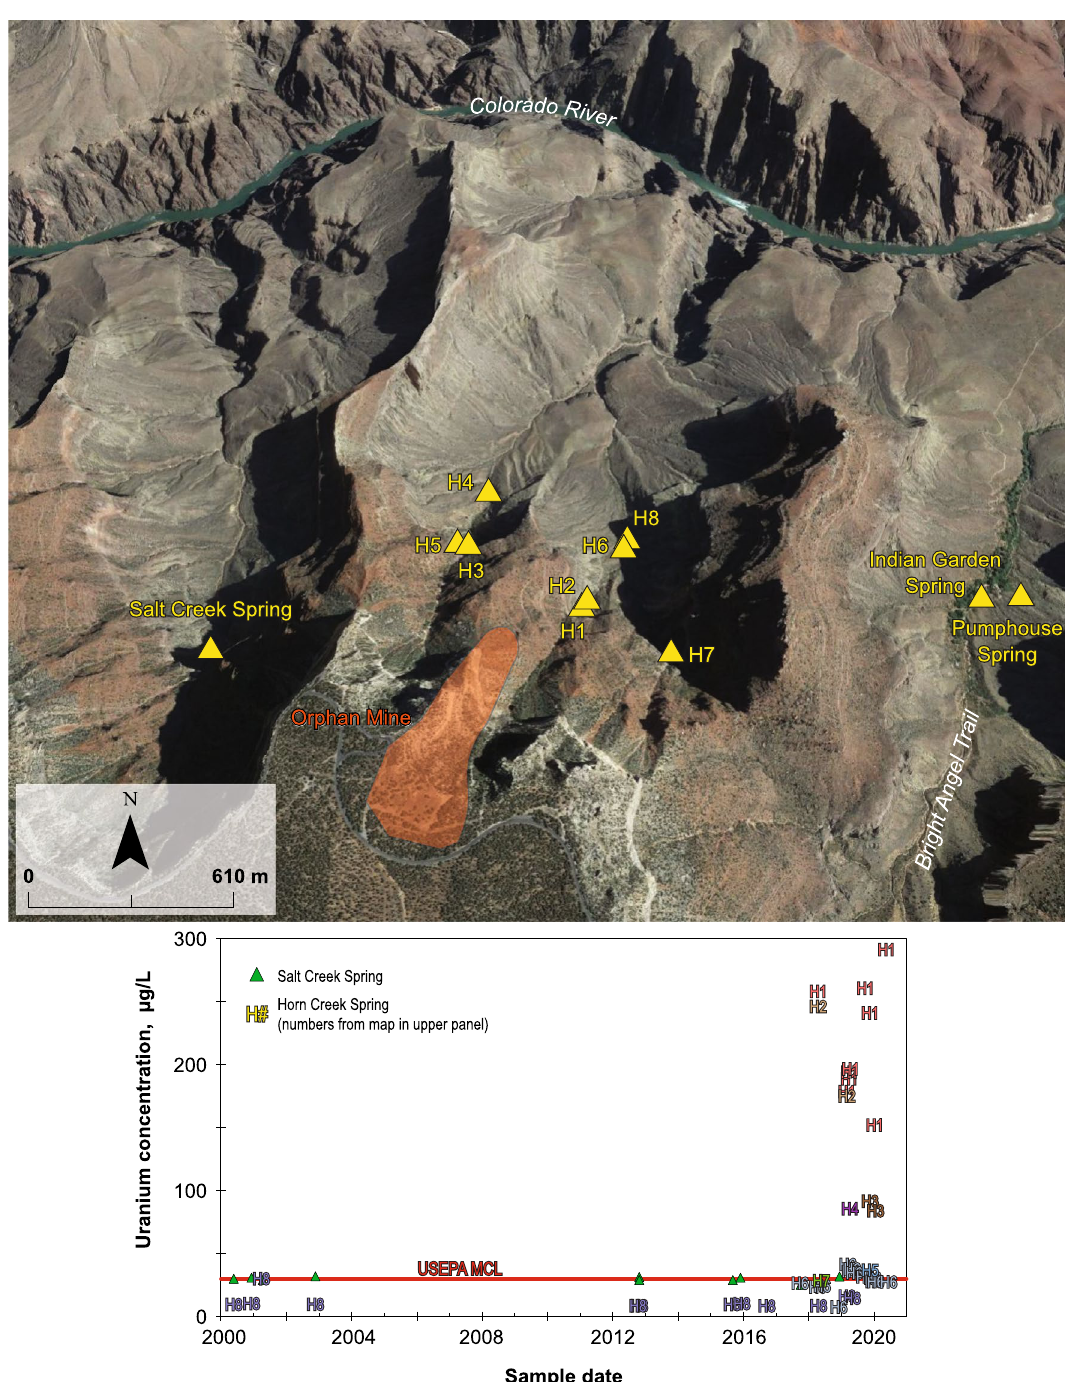
Figure 6. Map of former Orphan Mine uranium mine with location of nearby springs (upper panel) and time series chart of uranium concentrations in springs in the Horn and Salt Creek drainages (lower panel). Springs in the Horn Creek drainage are labeled from highest to lowest uranium concentration (H1, H2, etc.) in both panels. Created in Adobe Illustrator 25.4.1 (https:// www. adobe. com/ produ cts/ illus trator. html). Oblique imagery from Google,